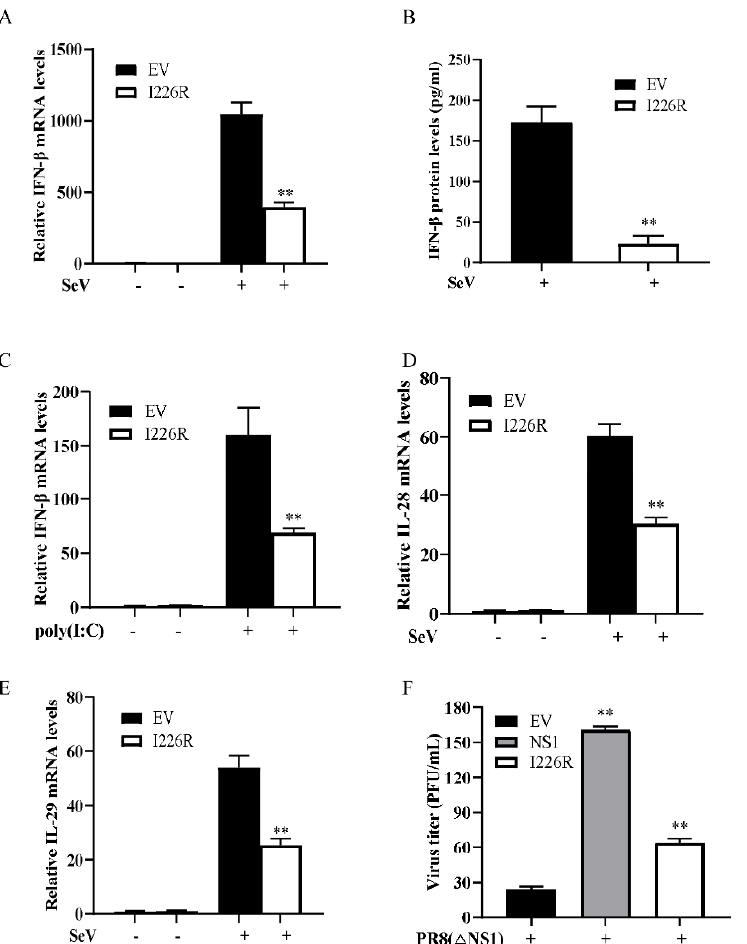
Figure 2. The I226R protein reduces the expression of IFNs induced by SeV and poly(I:C): ( A – C ) 293T cells were transfected with 3 µ g I226R-Flag plasmid or EV for 24 h; then, they were infected with SeV ( A , B ), or were transfected with 1 µ g/mL poly(I:C) ( C ) for 12 h. RT-qPCR and ELISA were performed to examine the expression of IFN- β mRNA and protein levels, respectively. ( D , E ) 293T cells were transfected with 3 µ g I226R-Flag plasmid or EV for 24 h; then, they were infected with SeV for 12 h. Expression levels of IL28 ( D ) and IL29 ( E ) were measured by RT-qPCR analysis. ( F ) 293T cells were transfected with 3 µ g EV, NS1(H7N9), or I226R-Flag plasmid for 24 h; then, they were infected with PR8 ∆ NS1 (MOI = 1) for 12 h. The supernatant of virus-infected cells was used for plaque assay. All the results are expressed as the means ± standard deviation from three independent